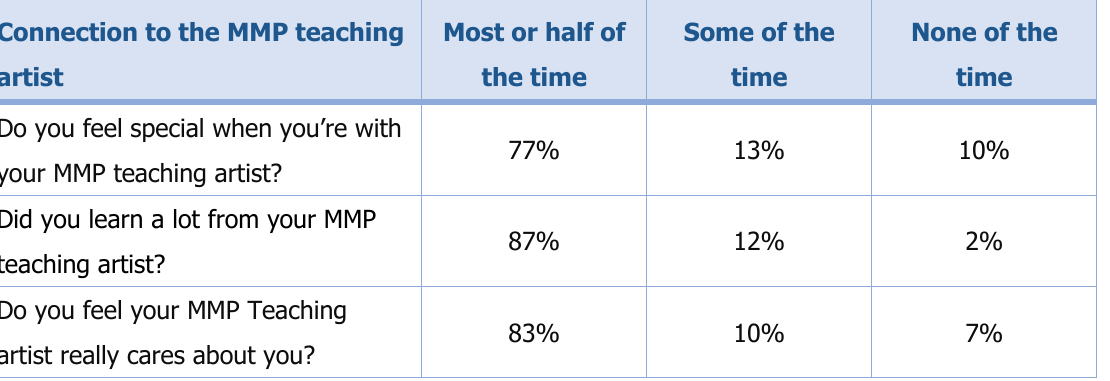
Table 4. Student Responses to Questions Regarding Connection to the MMP Teaching